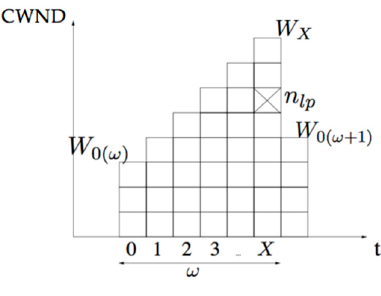
Figure 1. Evolution of CWND.